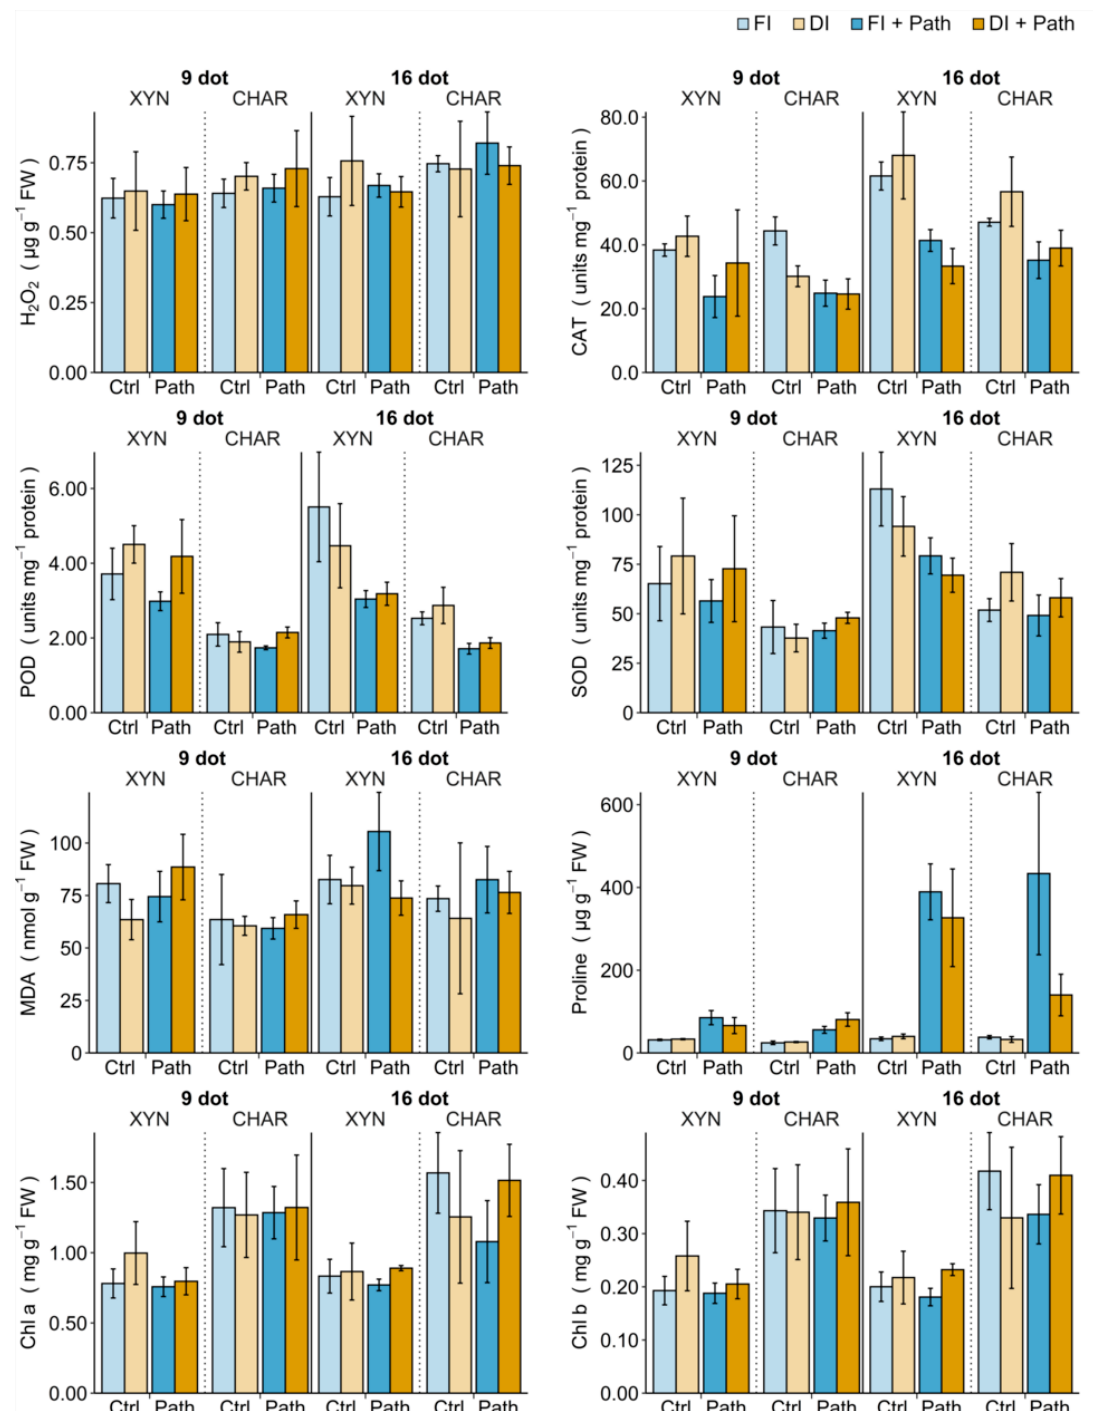
Figure 6. The impact of drought and pathogen stress on photosynthetic pigments and oxidative parameters. Xynisteri (XYN) and Chardonnay (CHAR) plants were subjected to 7 or 14 days of full (FI) or deficit (DI) irrigation before in planta inoculation with water (Ctrl) or P. viticola (Path) (continued exposure to full/deficit irrigation; see Figure 1). Samples for analysis were taken at 1.5 days post inoculation (dpi), corresponding to 9 or 16 days of irrigation treatment (dot). Each treatment consisted of five repetitions. For the effect of drought stress, the fully irrigated and deficit-irrigated control plants should be compared. For the effect of pathogen stress, water-inoculated and pathogen-inoculated fully irrigated plants should be compared. The bars and error bars show the mean and the standard deviation, respectively. Abbreviations: see Table 1.